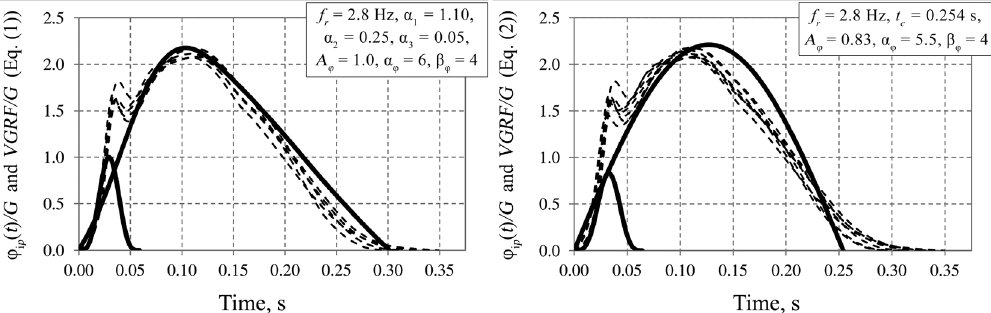
( t )/ G with the VGRF / G ip φ